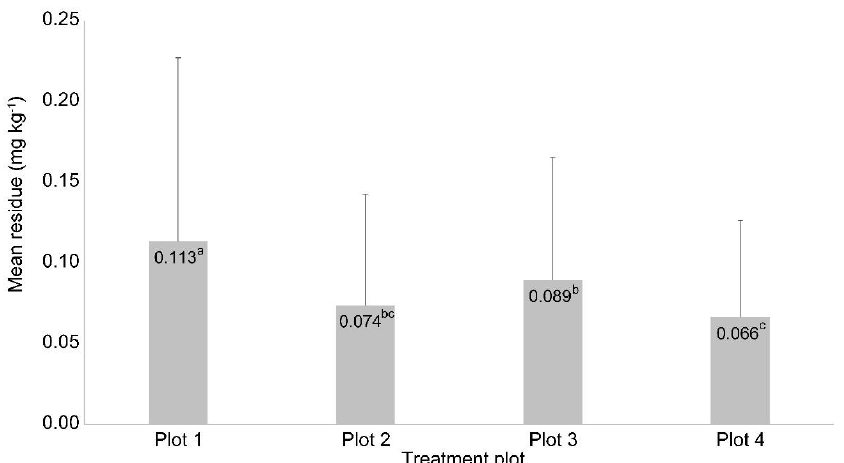
Figure 5. Residues of picarbutrazox with standard deviation in Chinese cabbage at different dilution rates and multicopter speeds. Plots 1 and 2, 16-fold dilution, 2 and 3 m s −1 multicopter speeds, respectively; plots 3 and 4, 32-fold dilution, 2 and 3 m s −1 multicopter speeds, respectively. Different letters indicate significant differences at p < 0.05 based on least significant deviation.